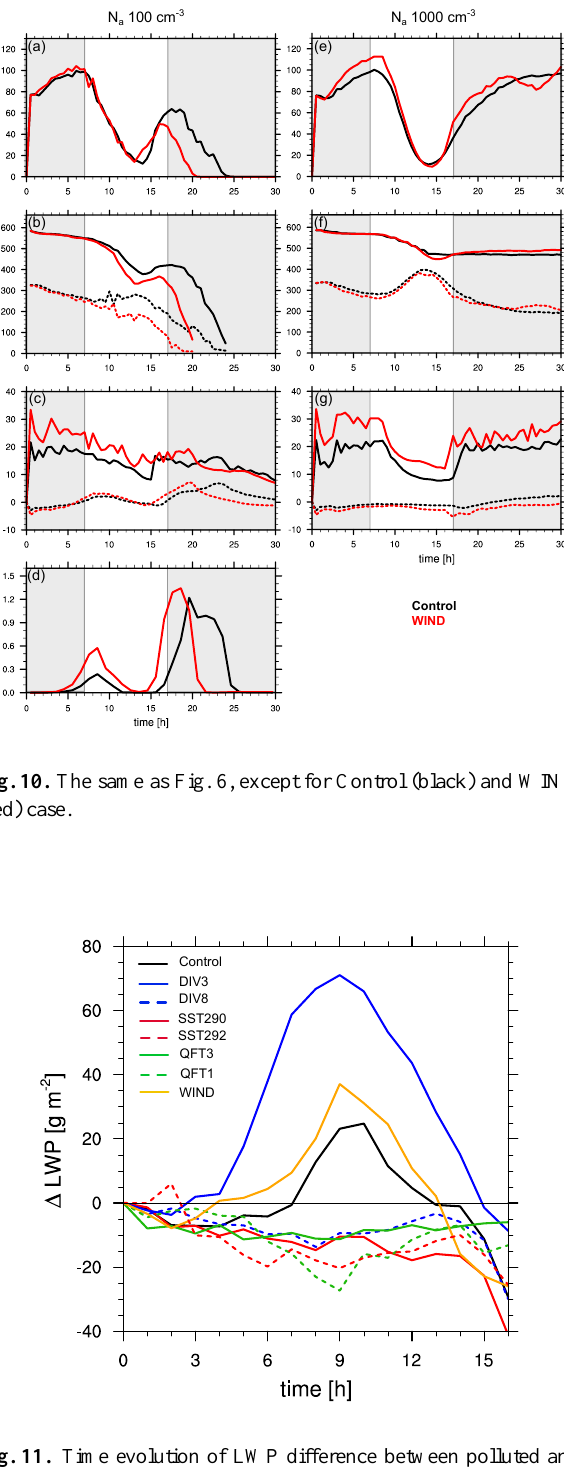
Fig. 11. Time evolution of LWP difference between polluted and clean condition for Control (black), SST290 (red solid), SST292 (red dashed), QFT3 (green solid), QFT1 (green dashed), DIV3 (blue solid), DIV8 (blue dashes), and WIND (orange) case.